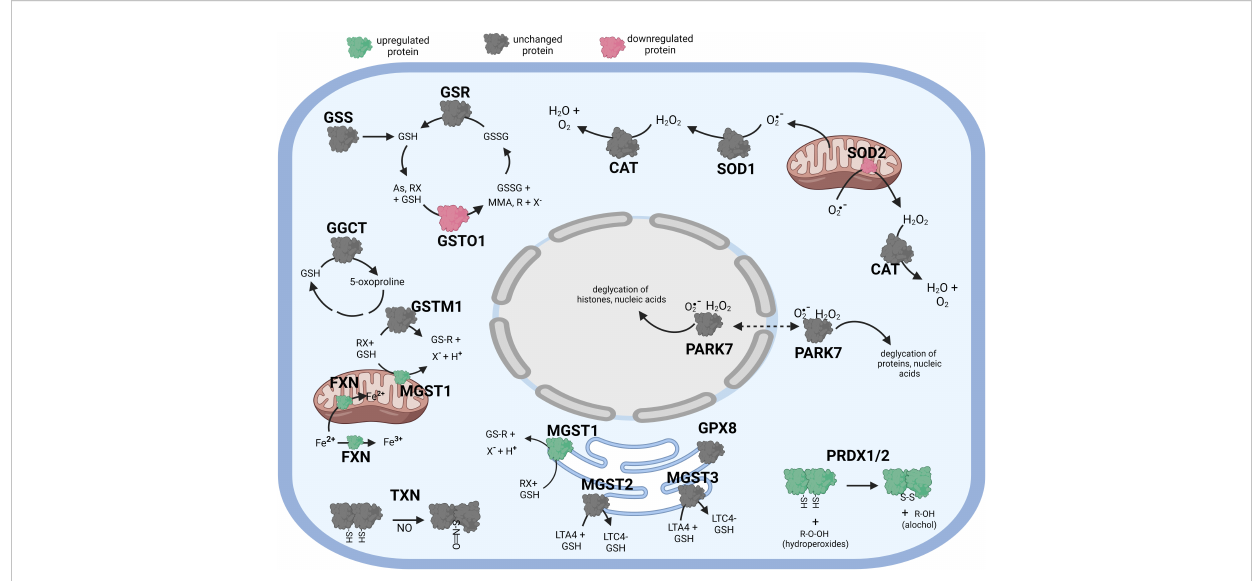
FIGURE 4 Diagramatic summary of the effect of a T pretreatment- tBHP post-treatmnet versus tBHP treatment alone on antioxidant protein expression. The antioxidant proteins focused on in this study are either upregulated (green), downreuglated (red) or unaffected (no change in expression) (grey) by exposure to a T. The arrows indicate athe direction of a chemical reaction. Exposure of hTERT RPE cells to a T followed by tBHP led to fewer upregulated antioxidant proteins compare to tBHP or a T alone, but there was an increase in MGST1, PRDX1, PRDX2 and FXN. Figure created with